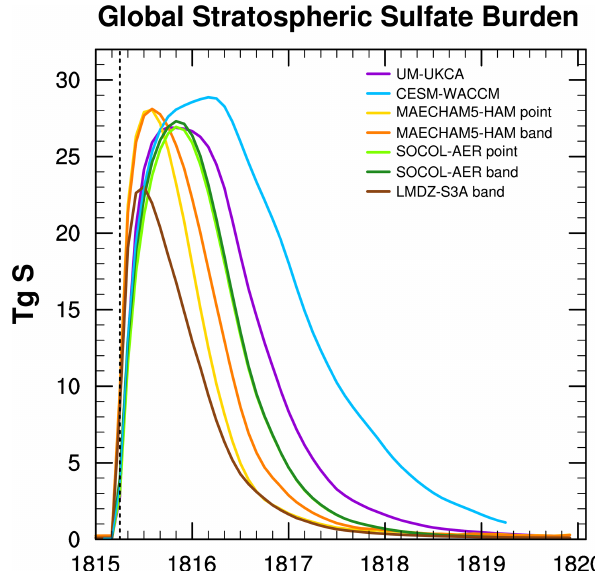
Figure 2. Global stratospheric burden of SO 4 in TgS vs. time. The vertical dashed black line indicates month of